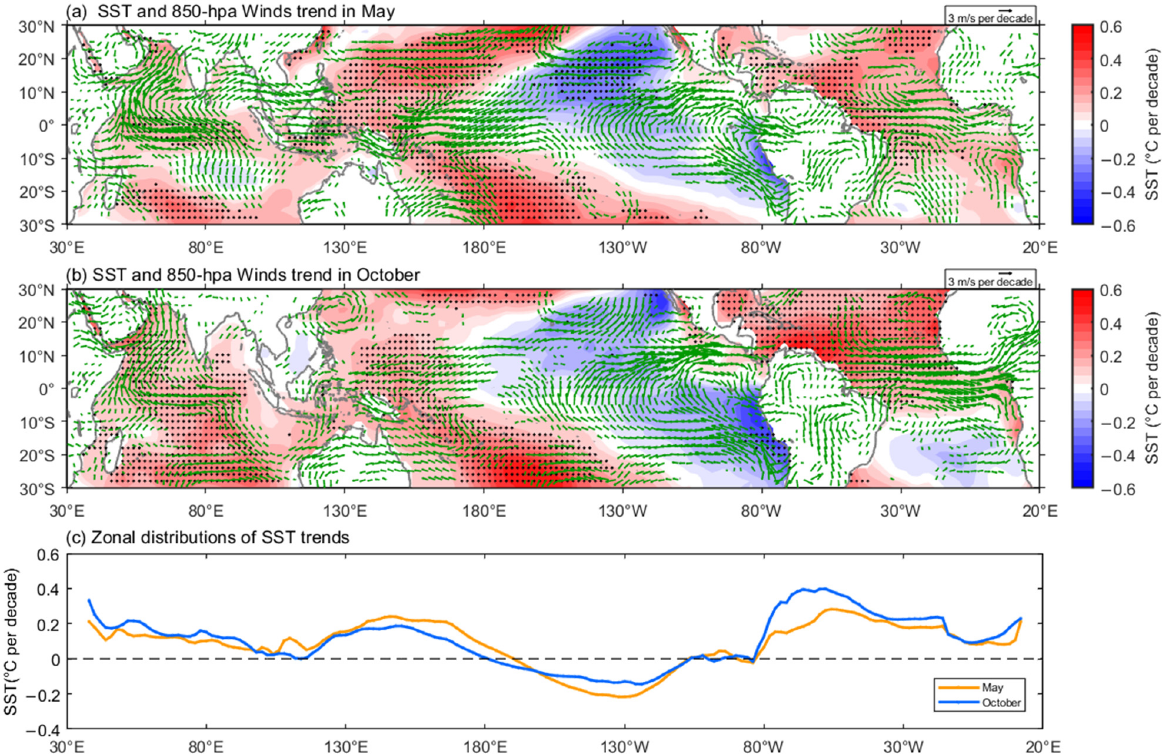
Figure 10. Comparisons for spatial distributions of SST trends in tropical ocean regions between May and October. Linear trends of SST (color) and 850-hPa winds (vectors) in ( a ) May and ( b ) October. ( c ) The zonal distributions of SST trends averaged between 5° S and 20° N for May (yellow) and October (blue). Signals above the 90% confidence level are highlighted by black dots (for SST) and green vectors (for winds).